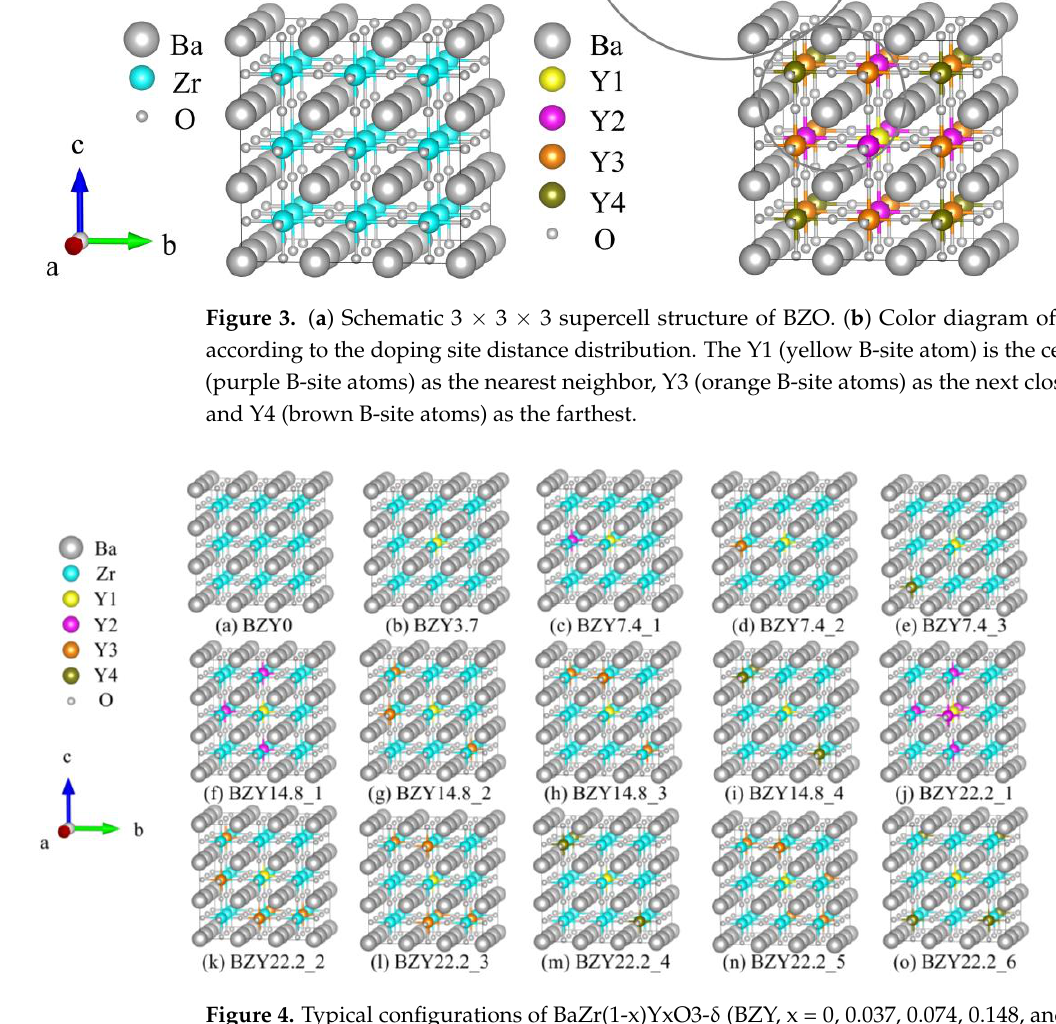
Figure 4. Typical configurations of BaZr (1-x) Y x O 3- δ (BZY, x = 0, 0.037, 0.074, 0.148, and 0.22).